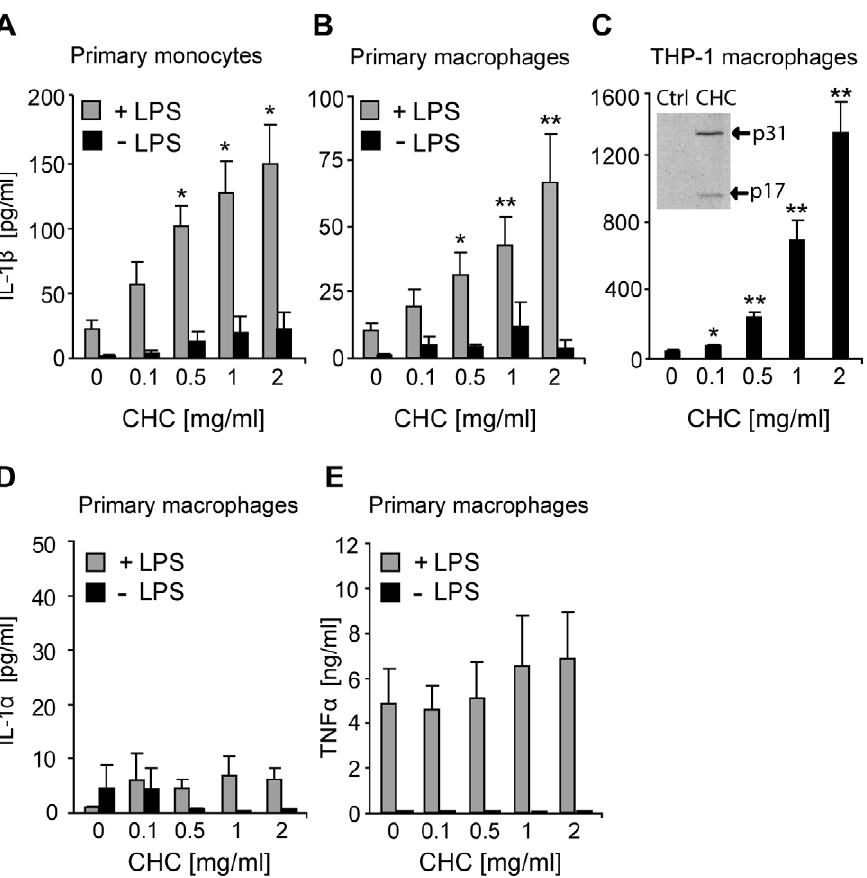
Figure 2. Monocytes and macrophages respond to cholesterol crystals (CHCs) by IL-1 b secretion. Primary monocytes (A), primary macrophages (B,D,E), and THP-1 macrophages (C) were incubated with CHCs for 16 h, 24 h, and 8 h, respectively. LPS (1 m g/ml) was used as a co- stimulant for the primary cells. Concentrations of cytokines were subsequently determined from cell culture supernatants. The inset in 2C verifies the presence of mature 17 kDa IL-1 b in cell culture supernatants of THP-1 macrophages by Western blotting. The data are means 6 s.e.m. from $ 4 experiments. *=p , 0.05 and **=p , 0.01, compared to untreated cells.